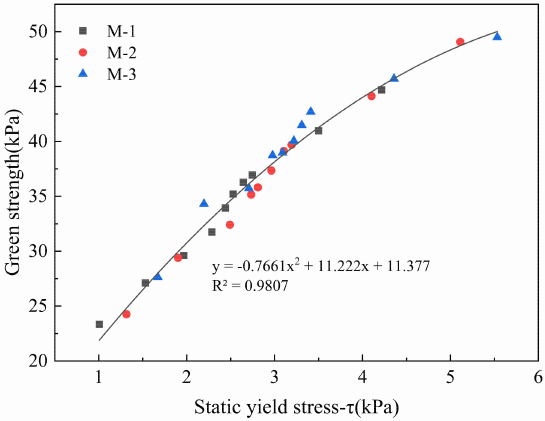
Figure 15. The fitted results of green strength value and static yield stress